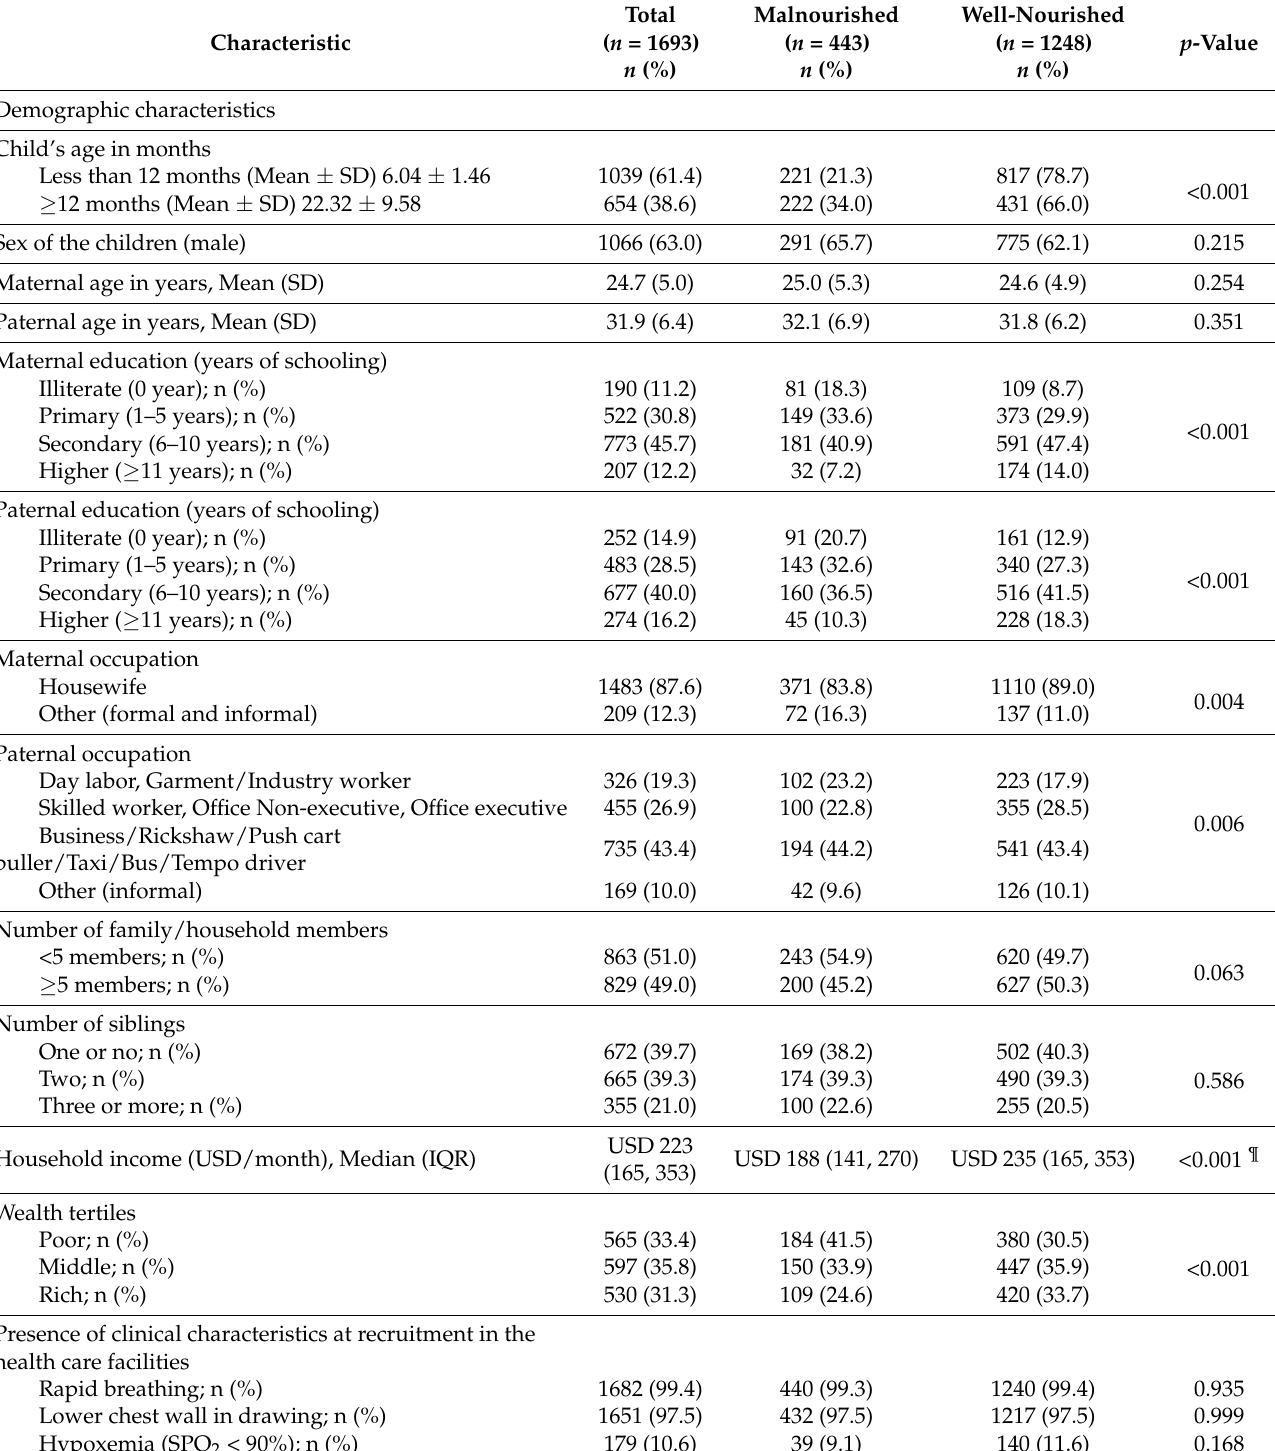
Table 1. Basic Demographic and Clinical Characteristics of the Study Children at